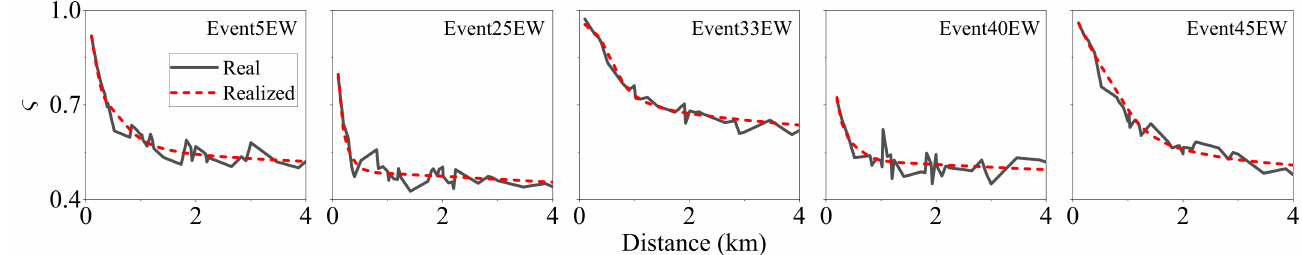
Figure 15. Similarities realized by the novel